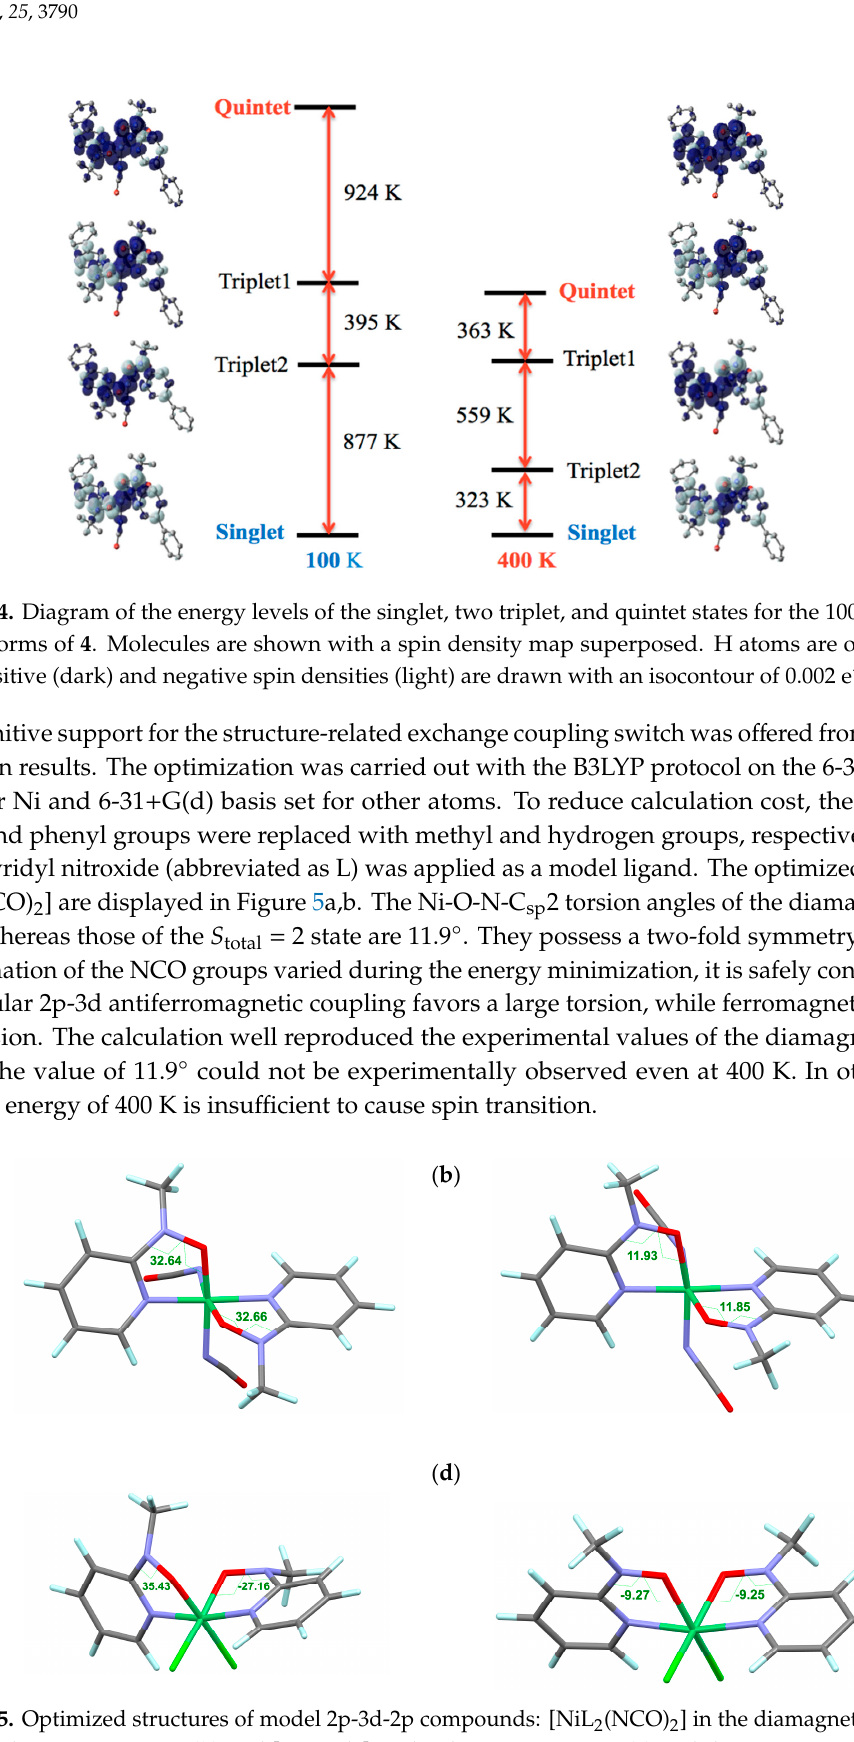
Figure 5. Optimized structures of model 2p-3d-2p compounds: [NiL 2 (NCO) 2 ] in the diamagnetic state ( a ) and the S total = 2 state ( b ) and [NiL 2 Cl 2 ] in the diamagnetic state ( c ) and the S total = 2 state ( d ), where L stands for methyl 2-pyridyl nitroxide. The Ni-O-N-C sp 2 torsion angles are indicated. Color codes: green, Ni; black, C; turquoise, H; blue, N; red,